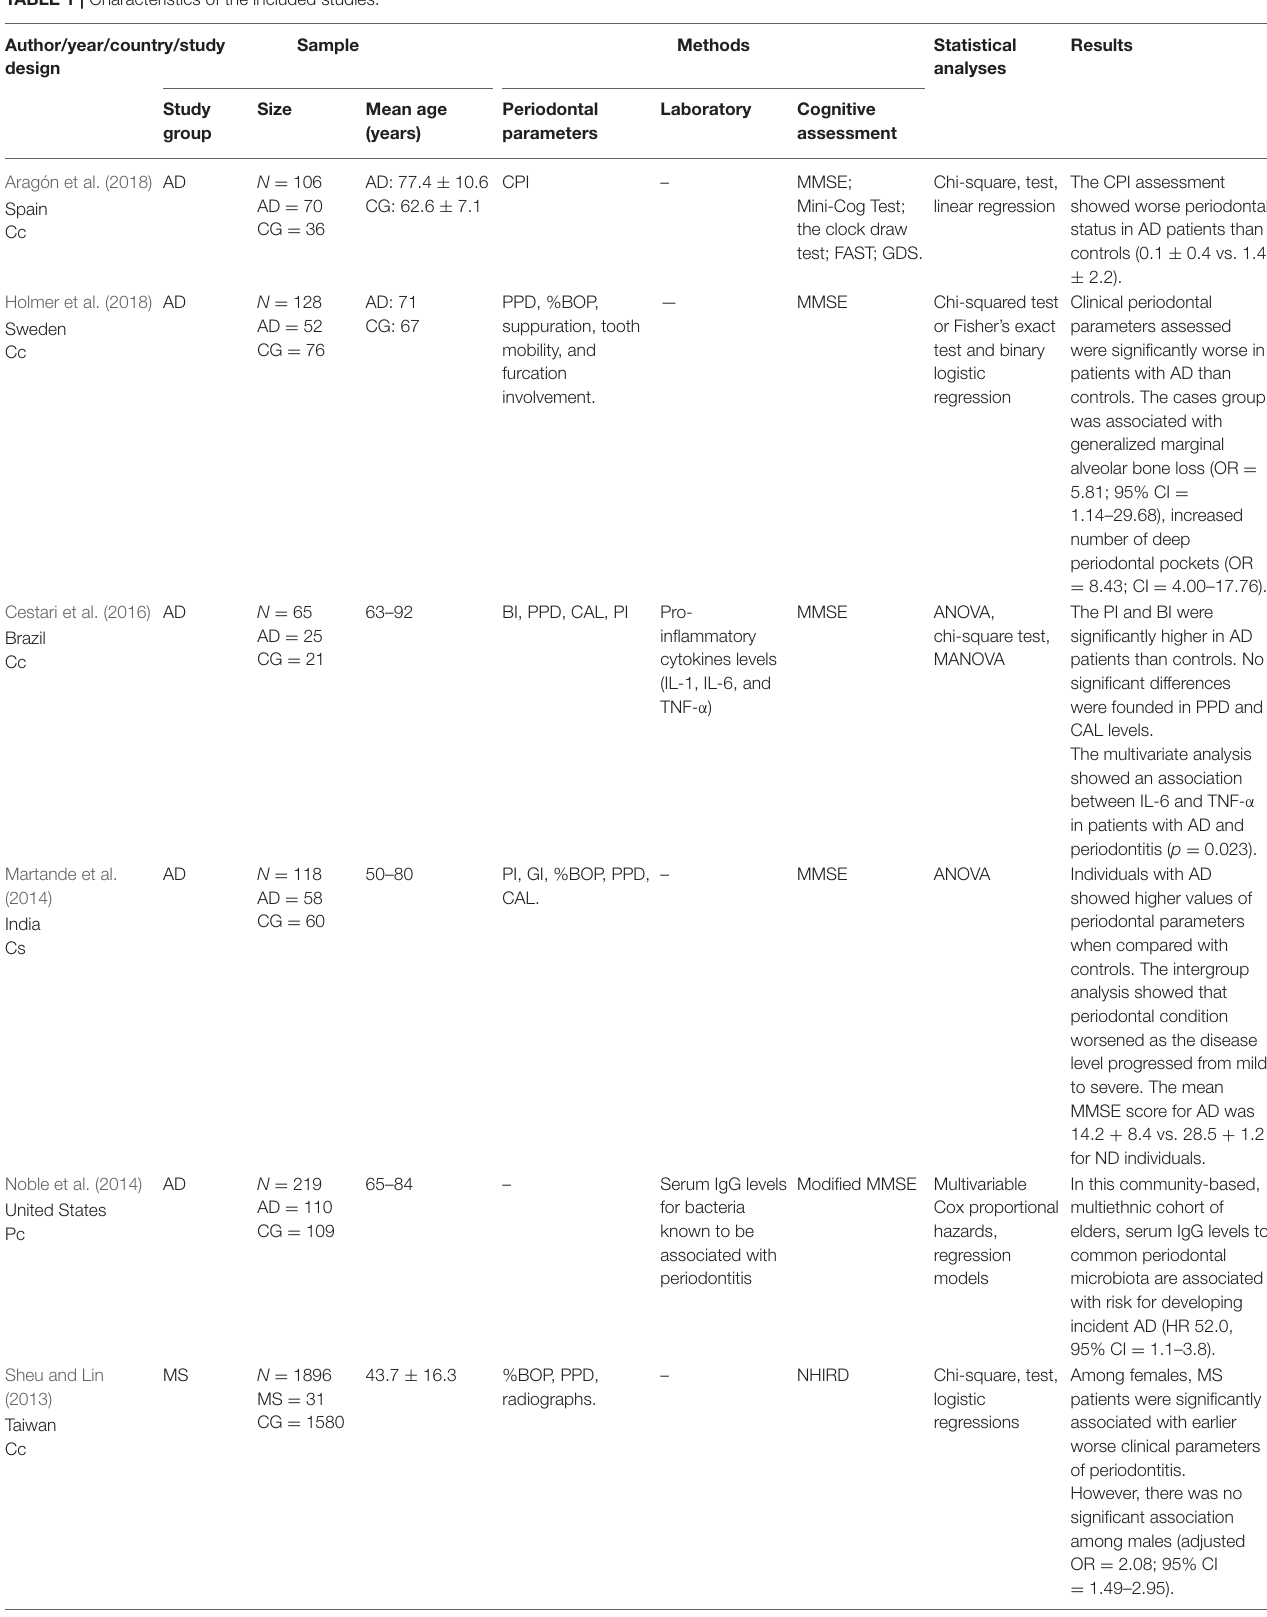
TABLE 1 | Characteristics of the included